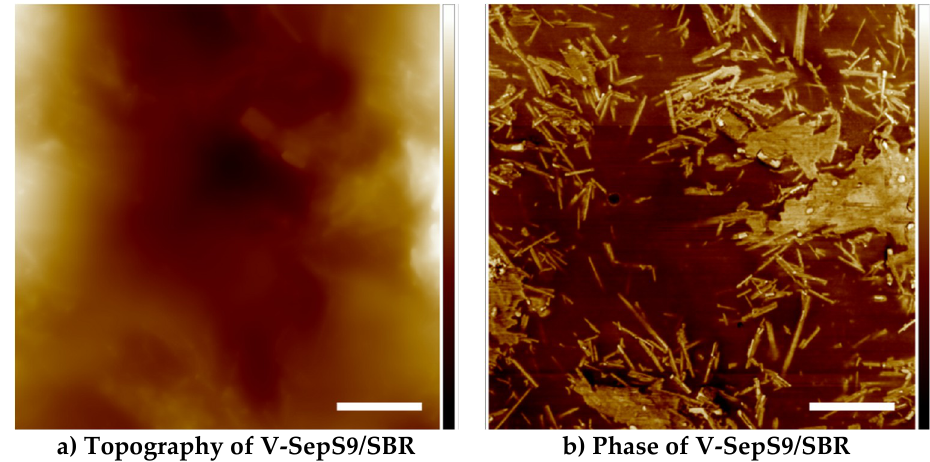
Figure 7. Tapping-Mode ( TM) topographic ( a ) and phase ( b ) images of V-SepS9/SBR PNC. The white scale bar is 1.0 μm. The Z-range is 1.0 μm and the phase scale is 25 degrees.